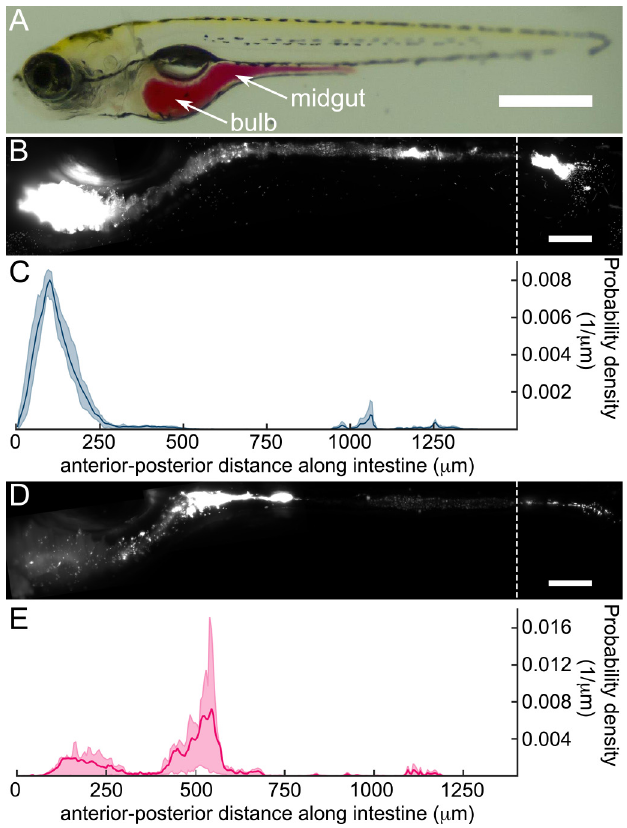
Fig 2. Vibrio and Aeromonas have distinct community architectures and biogeographies within the larval zebrafish intestine. (A) A larval zebrafish at 5 dpf; the intestine is highlighted by phenol red dye via microgavage [27]. Scale bar: 500 μ m. (B) A maximum intensity projection (MIP) of Vibrio in the larval intestine. Scale bar: 100 μ m. (C) The probability density of Vibrio along the intestinal axis. From (B) and (C), we see that Vibrio is predominantly localized in the anterior bulb. (D) MIP of Aeromonas in the larval intestine. Scale bar: 100 μ m. (E) The probability density of Aeromonas along the intestinal axis. (D) and (E) show that Aeromonas is predominantly localized in the midgut, with a smaller population in the anterior bulb. Underlying data for C and E are provided in S1